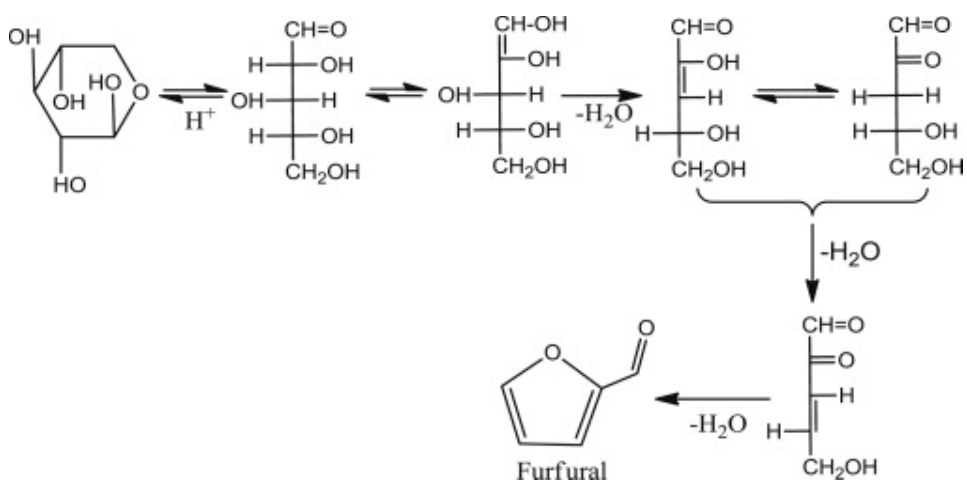
Figure 2. Catalytic formation of furfural from pure xylose [29]. Reproduced with permission from Ref. [29].